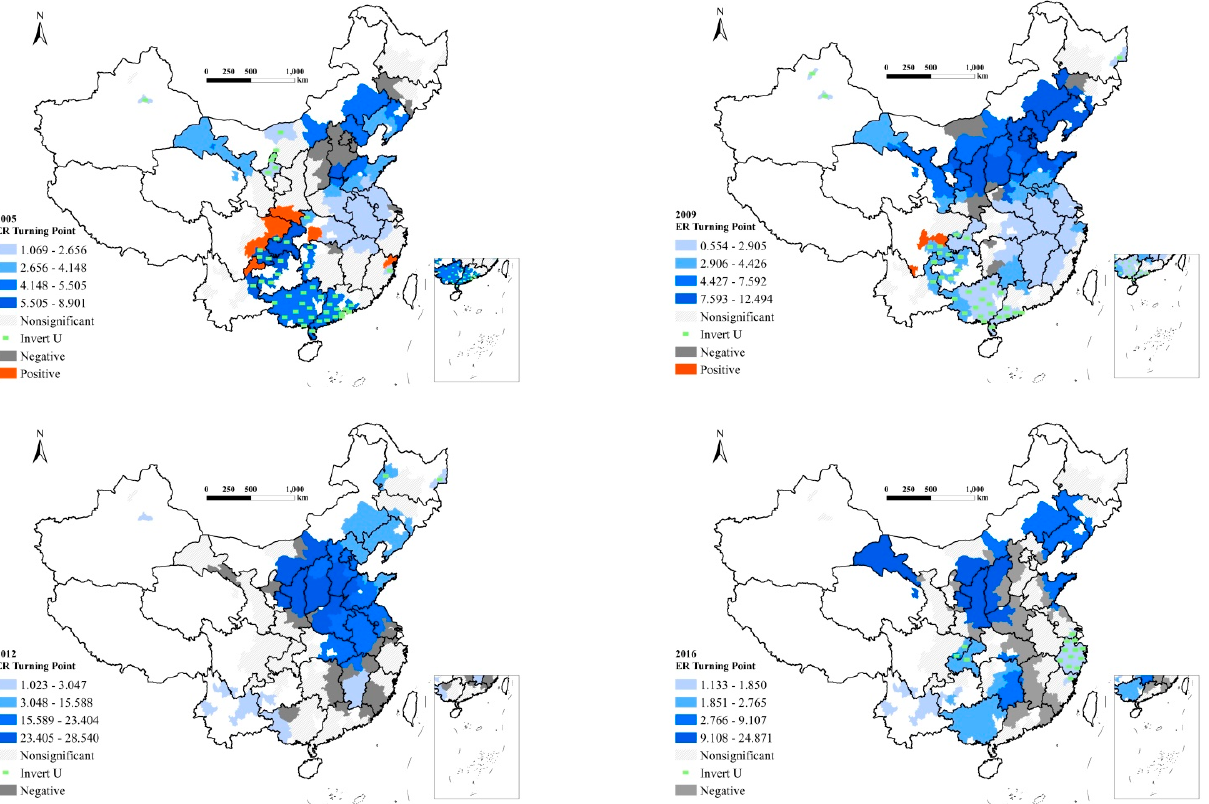
Figure 2. Spatiotemporal distribution of coefficients of environmental regulation in 259 cities.